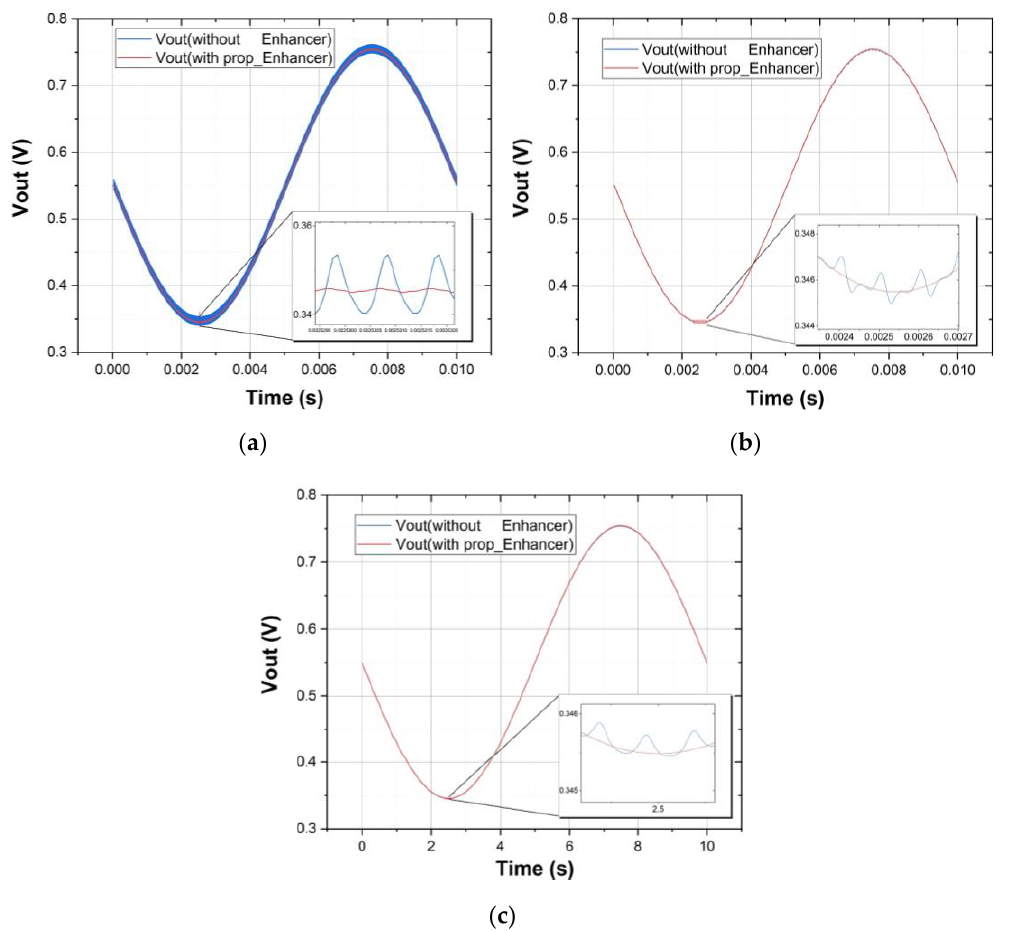
Figure 14. Comparison of time-domain output responses of DDAs with and without proposed enhancer at different noise